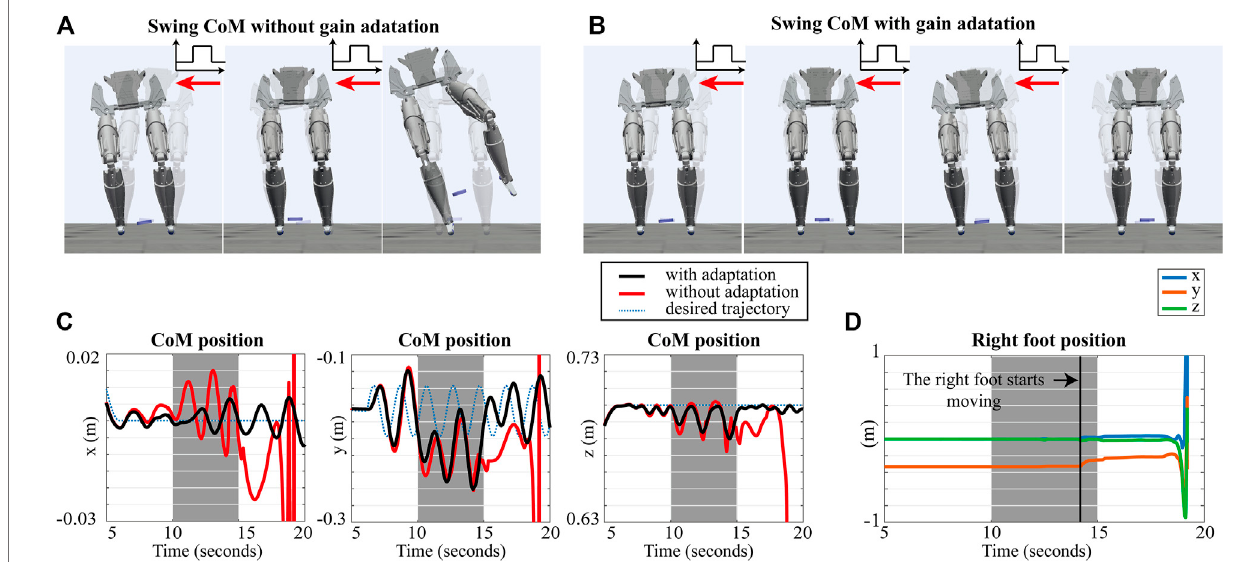
FIGURE 5 | Simulation results of CoM swing with unknown external force: (A) Snapshots of the simulation swinging CoM without the proposed gain adaption. (B) Snapshotsofthesimulationwiththeproposedgainadaptation. (C) ThePositionsoftherobot ’ sCoMwhileperformingaswingingmotion:x,y,andzpositionoftheCoM, (D) The right foot position without the adaptive gains.